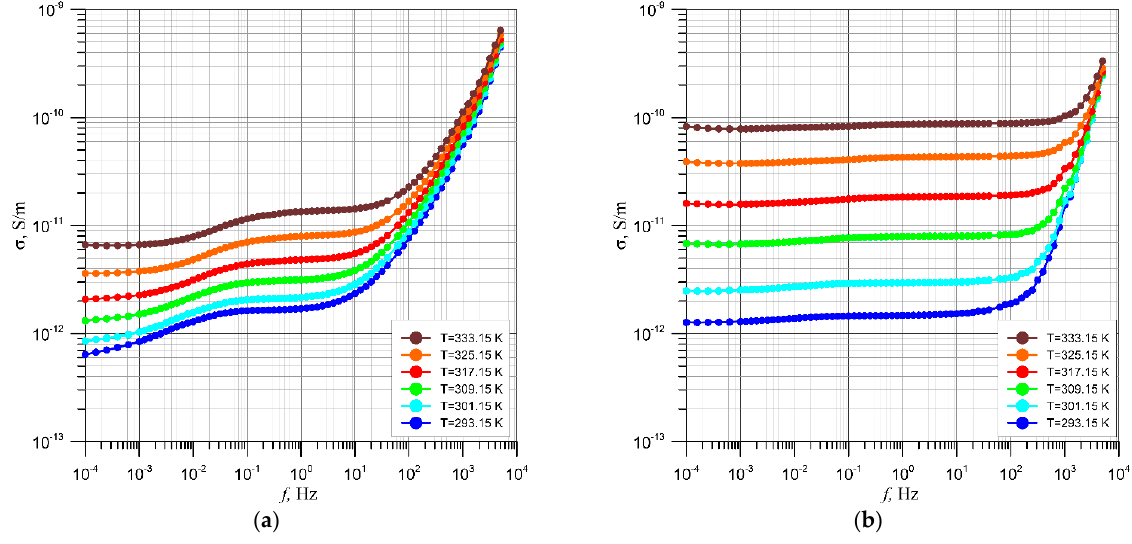
Figure 6. Frequency dependencies of the conductivity of mineral-insulating oil with a moisture content of 5 ppm—( a ) and moistened mineral oil—( b ) at temperatures from 293.15 K to 333.15 K in steps of 8 K.